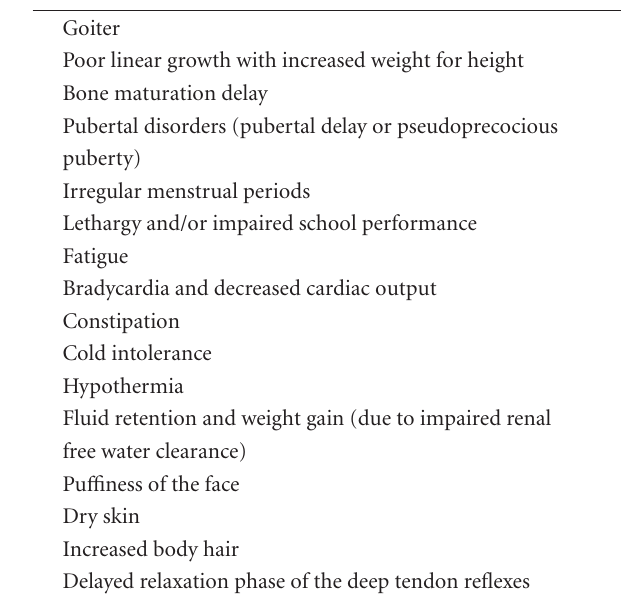
Table 1: Symptoms and signs of overt